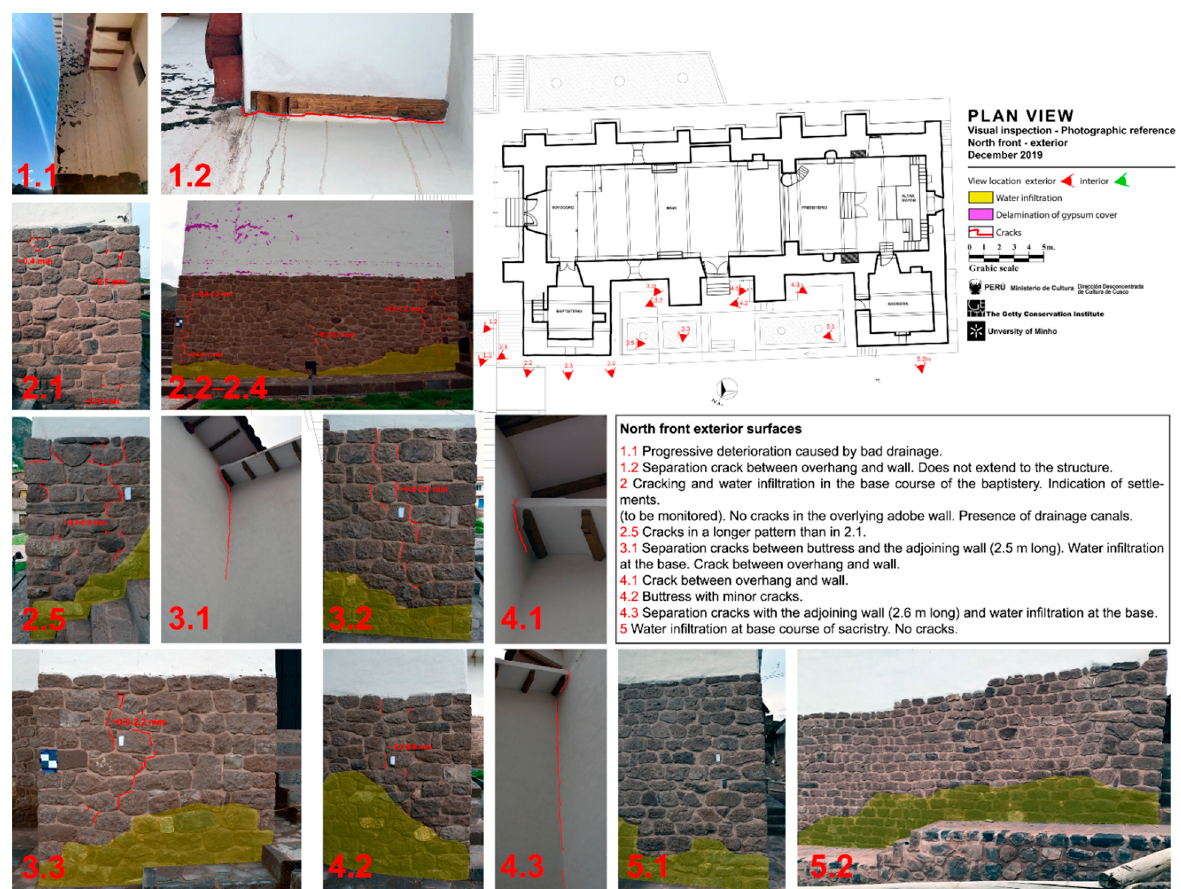
Figure 7. Set of documented damages comprised at the exterior surfaces of the south elevation. Note the photo references.